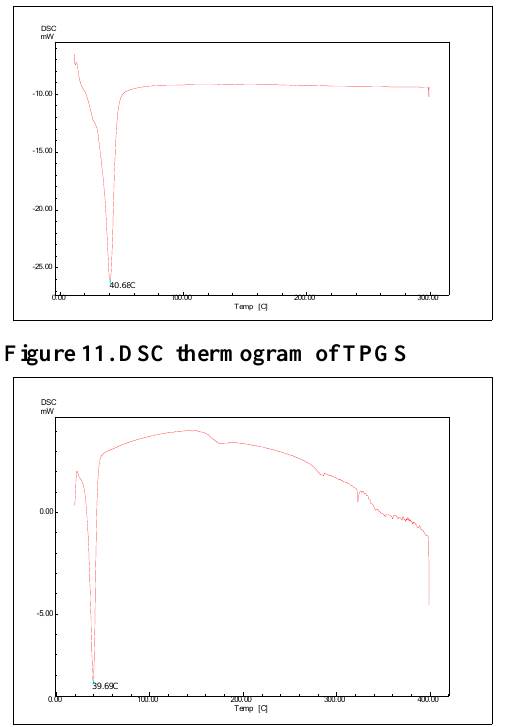
Figure 12. DSC thermogram of selected formula of REM-TPGS (SD